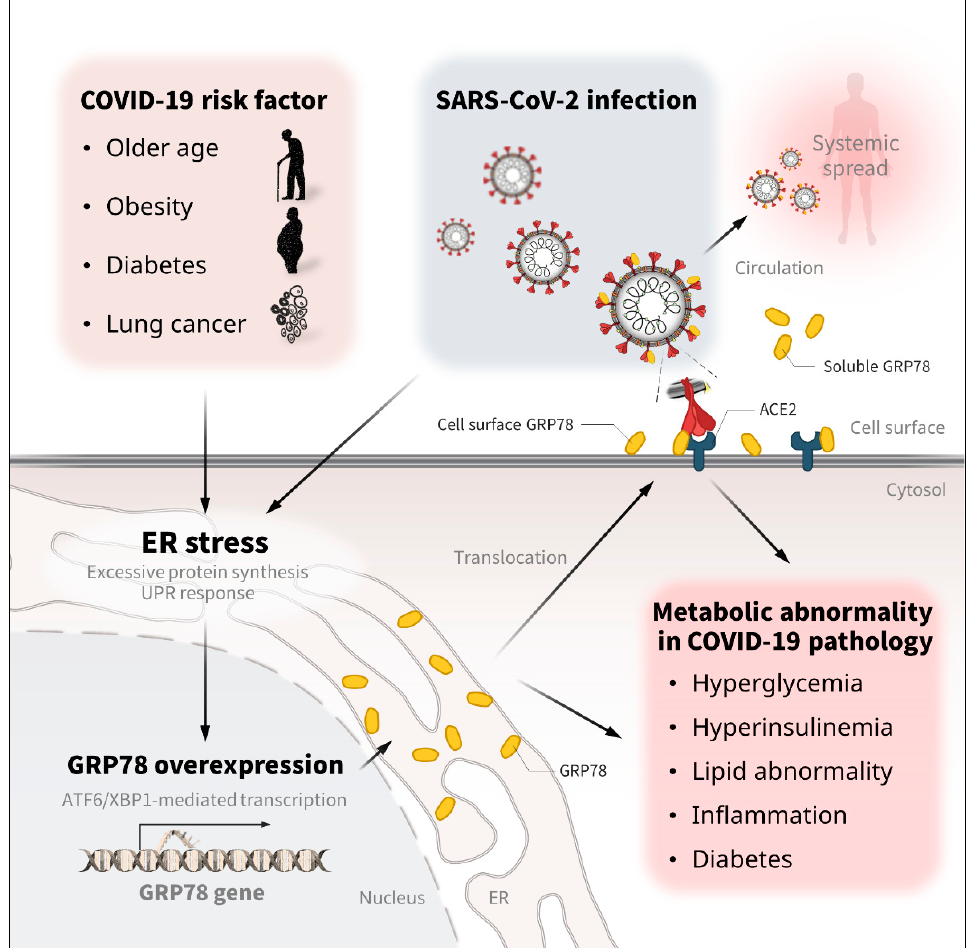
Figure 4. The regulation and metabolic association/implication of GRP78 in COVID-19. Older age, obesity, diabetes, and some types of lung cancer are known to be significant risk factors for COVID-19 severity and mortality [5–9]. Theses pathological conditions increase the expression of GRP78 [21–23,61]. SARS-CoV-2 infection is also associated with the overexpression of GRP78 in the lung and circulation [62,74]. The excessive protein production and UPR response in the ER compartment is attributed to GRP78 overexpression via ATF6/XBP1 transcription activity [12,89,90], which triggers the translocation of GRP78 to the cell surface and the circulation [30–32]. The excessive expression of GRP78 contributes to metabolic diseases, such as hyperglycemia, hyperinsulinemia, liver steatosis, abnormal lipid control, inflammation, insulin resistance, and diabetes[91–93]. Therefore, the infection- and stress-induced GRP78 expression might in part account for the metabolic abnormalities of COVID-19.